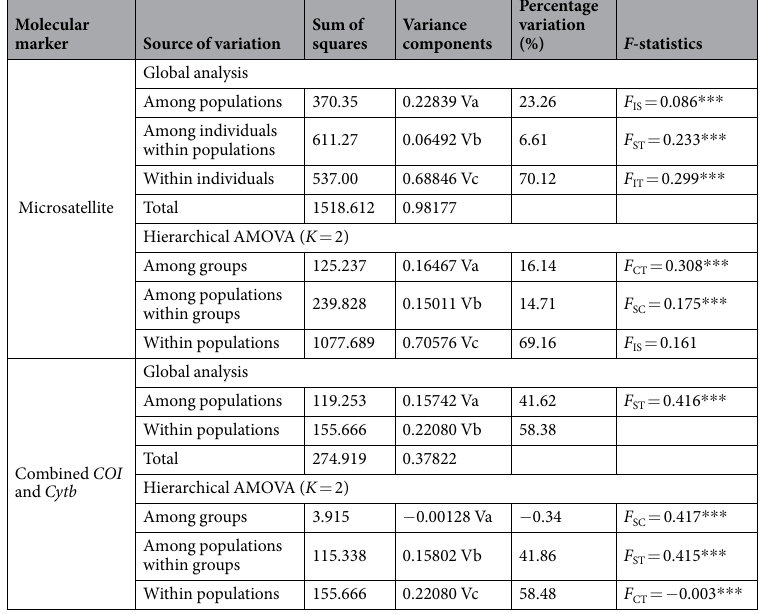
Table 1. Results of analysis of molecular variance (AMOVA) test on microsatellite and mtDNA markers in different populations of Aphis gossypii in China. *** P < 0.001. Two groups including eastern region group and western region group based on STRUCTURE analysis (See Fig.